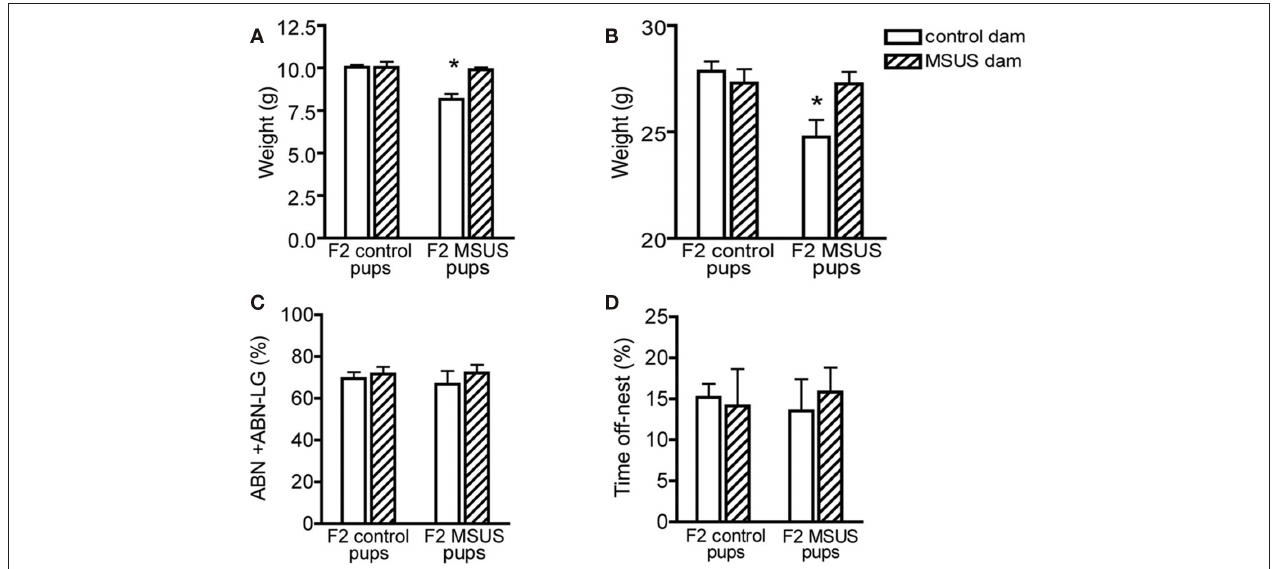
FigUrE 5 | Postnatal development in F 2 offspring. (A,B) Control pups cross-fostered to MSUS dams had normal body weight at (A) weaning ( n = 28) and (B) in adulthood ( n = 29), but F 2 MSUS pups cross-fostered to F 2 control dams had decreased body weight at (A) weaning ( n = 27) and (B) in adulthood ( n = 25), compared to control pups raised with their biological dams (weaning, n = 92; adult, n = 89) and MSUS pups raised with their biological dams